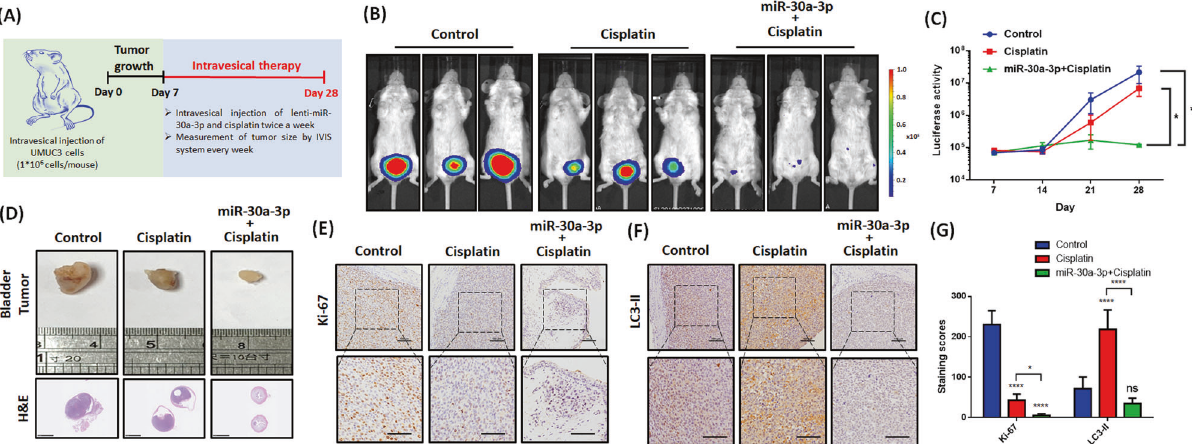
Fig. 8 Administration of cisplatin and hsa-miR-30a-3p signi fi cantly reduce tumor growth. A Flowchart showing an in vivo tumor-xenograft mouse model. Luciferase-positive BC UMUC3 cells (1 × 10 6 cells) were injected into the bladders of SCID mice. After 1 week, the mice intravesically received twice-weekly lenti-miR-30a-3p plasmid and cisplatin (2.5 mg/kg) for 4 weeks. B , C Bioluminescent images using IVIS spectrum were performed weekly, and the luminescent intensity of photons emitted from each tumor in the images was quanti fi ed ( N = 3). D Tumor images representing excised tumors from each group and histologic sections of tumor were stained with H&E. E – G IHC staining exhibited Ki-67 and LC3-II expression in murine tumor tissues ( N = 3). All data are expressed as means ± SDs in triplicate samples. * P < 0.05 relative to the control group.